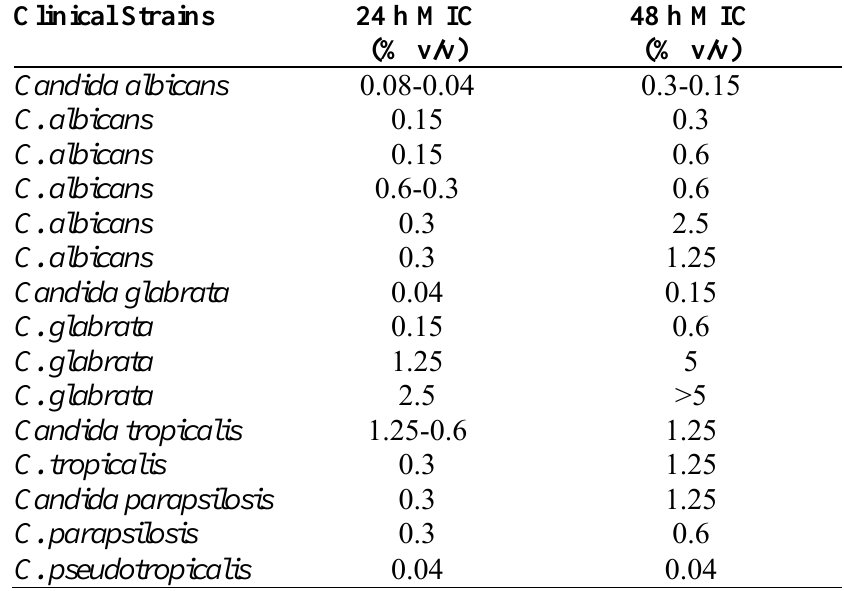
Table 4. Antifungal activity of R. anthopogon essential oil, evaluated by microdilution